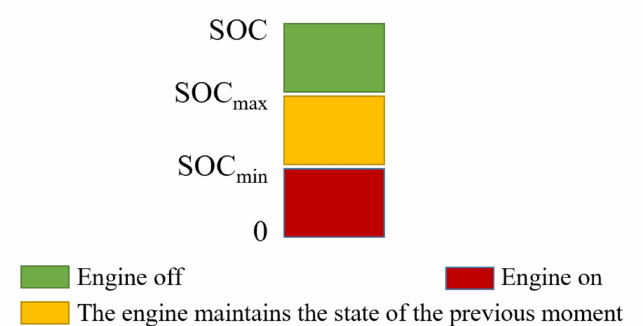
Figure 10. Operating principle diagram of the thermostat control strategy